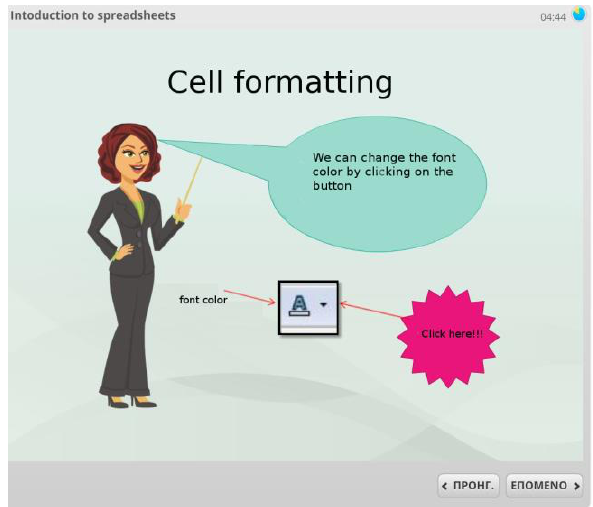
Figure 22. A screenshot from the implementation asking learners to click on a button In Figure 23, the results from the querying form show us that only 2 out of 46 students clicked on the image.